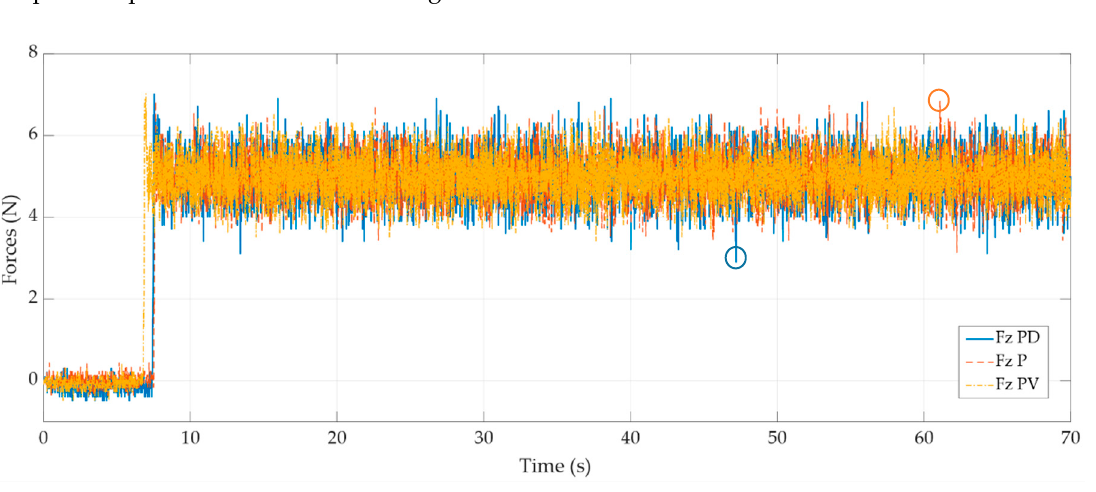
Figure 9. Proportional derivative (PD) vs. proportional with velocity feedback (PV) comparison.